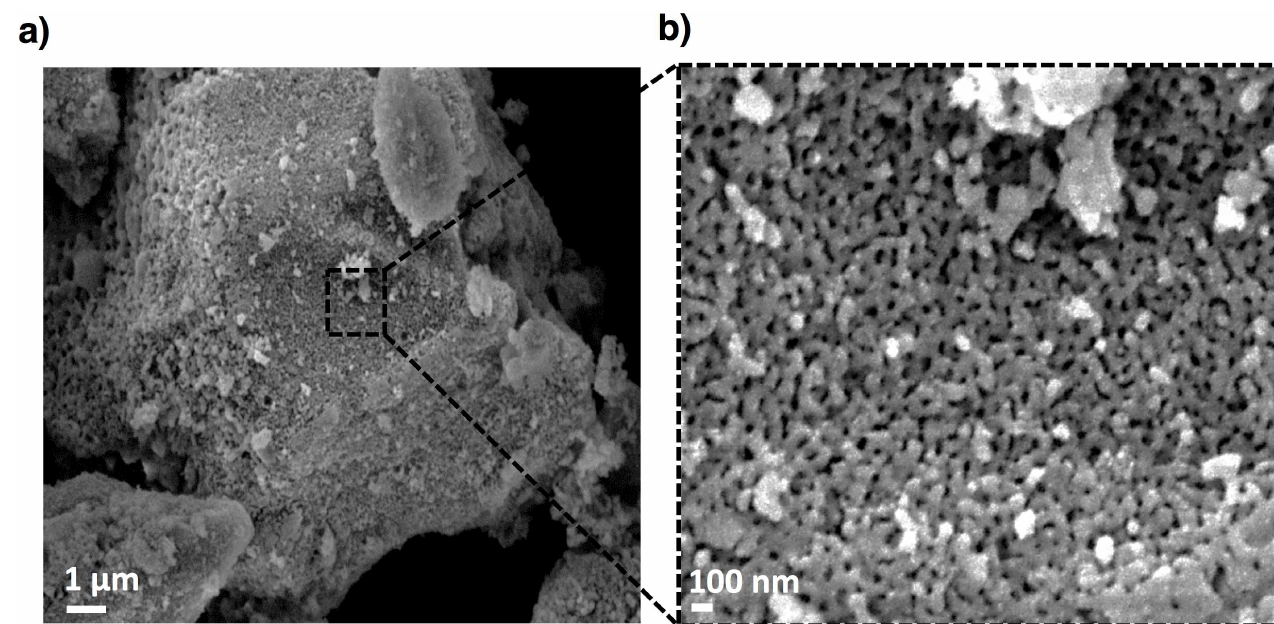
Fig 3. FESEM images and observed pSi microparticle surface morphology. ( a ) free standing pSi microparticle from magnesiumreduced tabasheer, reaction final product, ( b ) individualnanopores along the pSi particle surface (scale bar of ( a ) = 1 μ m, ( b ) = 100 nm.